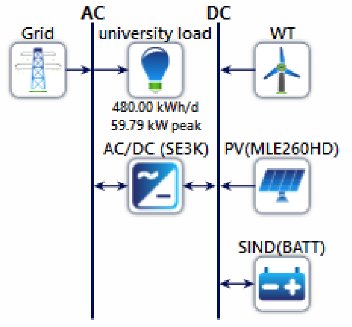
back to the main grid. The detailed analysis and mathemat- ical model of each component are presented in this